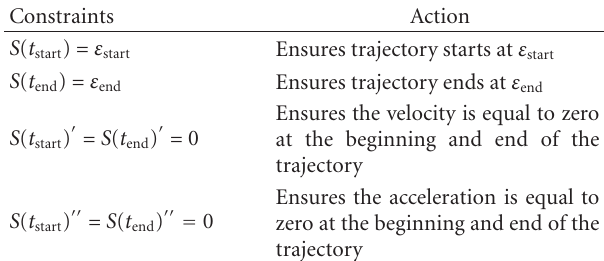
Figure 1: Conceptual view of the interpolation process through or near to clusters of acceptable mouth shapes for each viseme. Table 1: Boundary